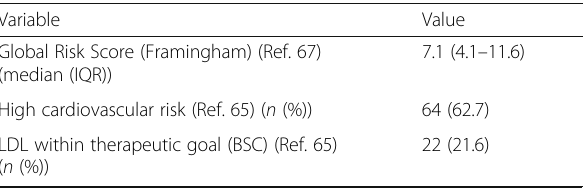
Table 1 Demographic, clinical and laboratory characteristics of